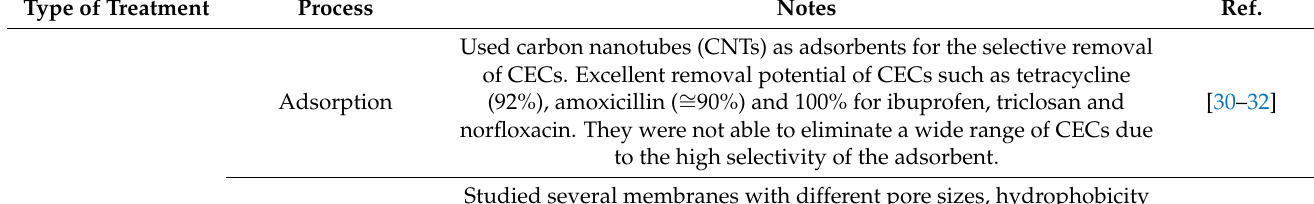
Table 1. Technologies for eliminating a wide range of contaminants of emerging concern (CECs) and mitigation of pathogenic organisms of effluents from secondary treatment. Type of